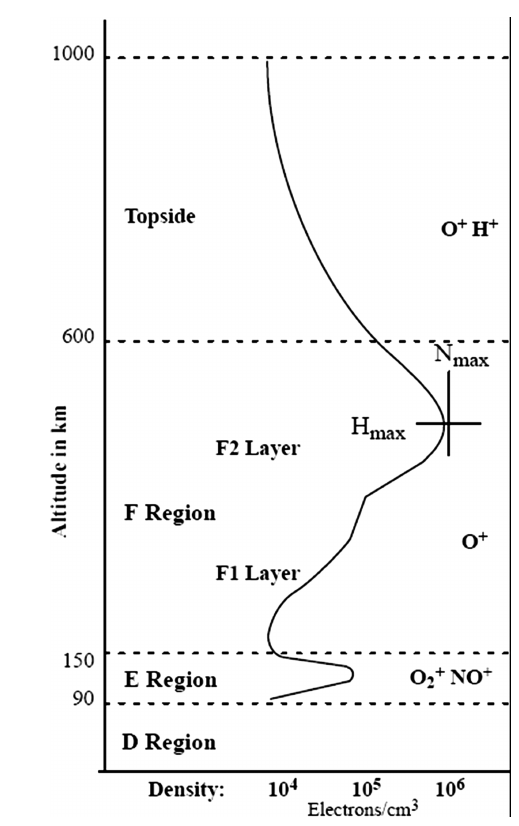
Figure 1. Vertical daytime profile of electron density.